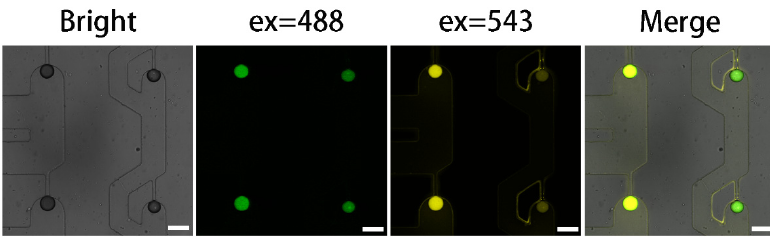
Figure 6. Optical and fluorescence microscope images of the autofluorescent BSA hydrogel microspheres (left) with and (right) without rhodamine B in parallel microchannels. All scale bars are 100 μ m.